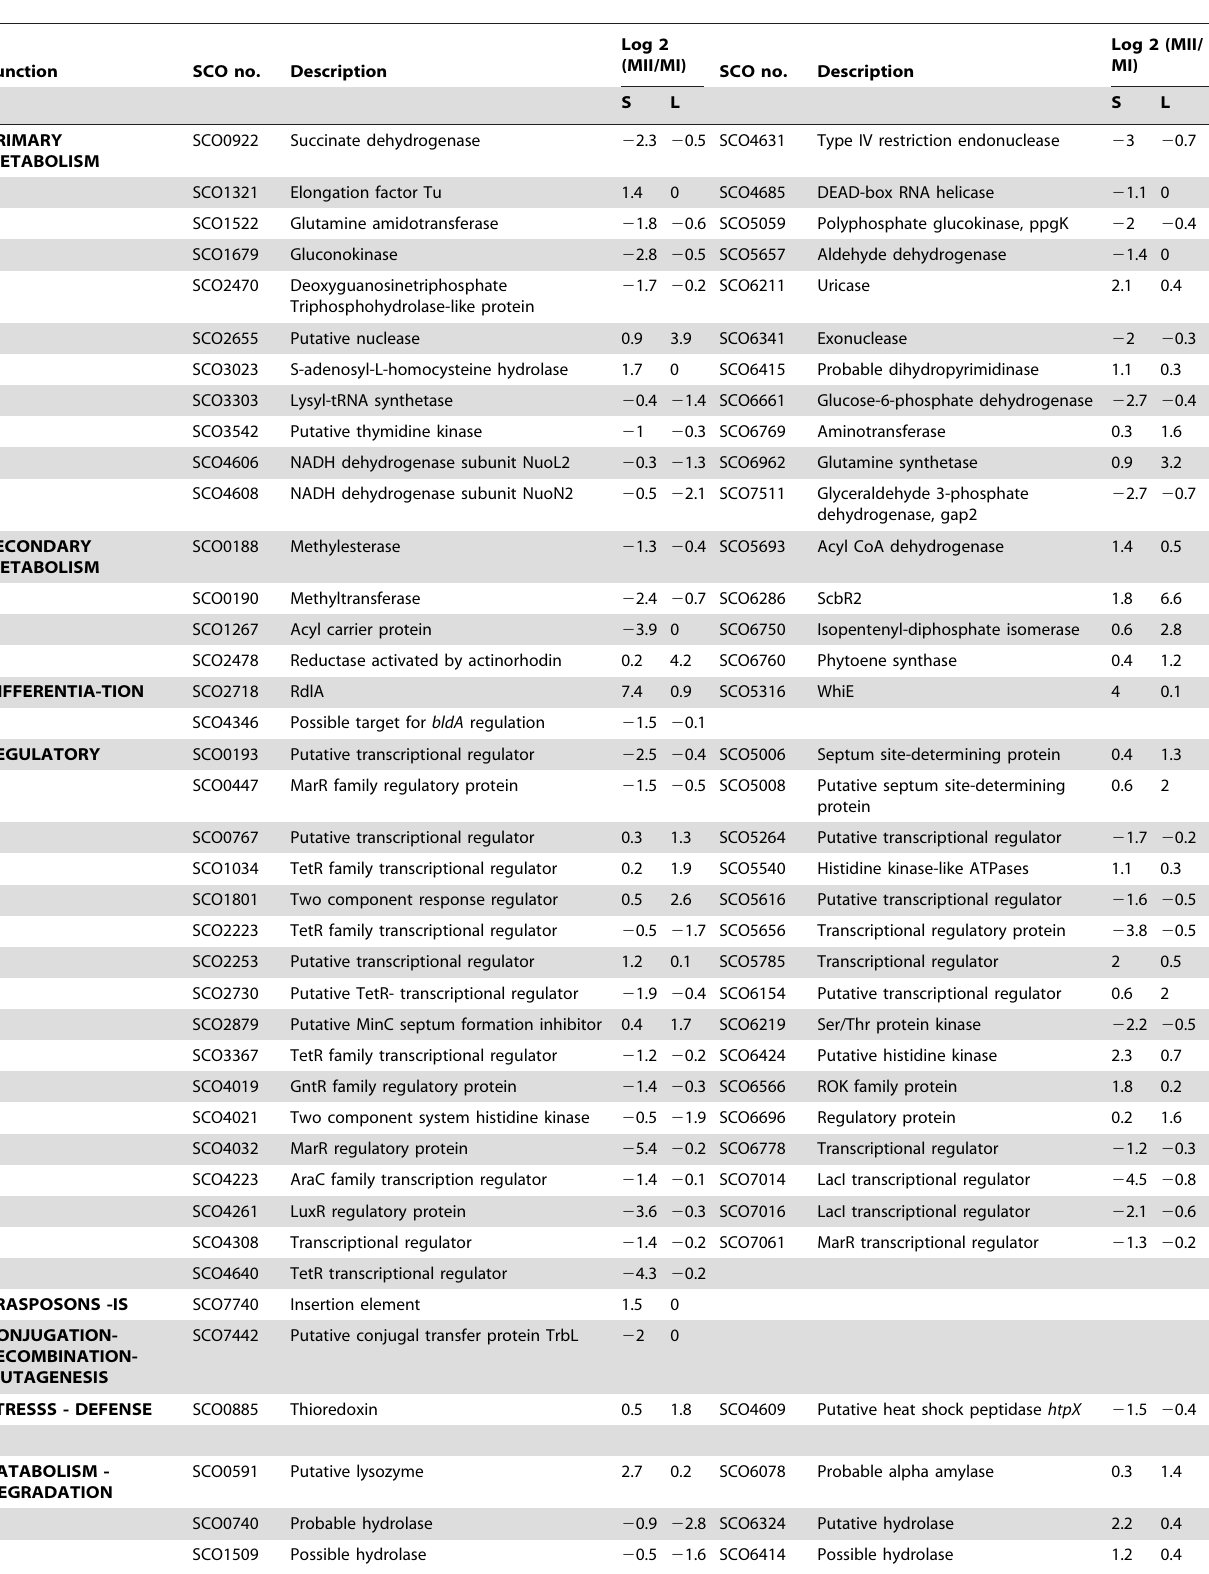
Table 2. Transcripts up- or down- regulated in MI or MII liquid and solid cultures, showing differences in their abundances (coefficient of variation between liquid and solid higher than 0.7).